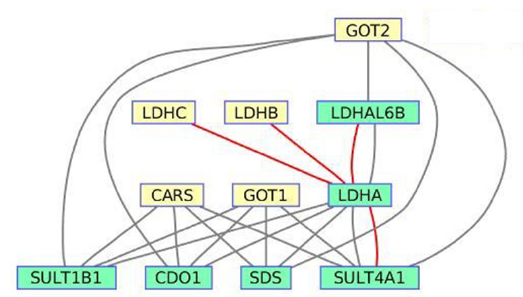
Figure 4. Gene–gene interactions in the CystM pathway induced by sirolimus. The red and black lines represent inhibition and activation, respectively. lines represent inhibition and activation,